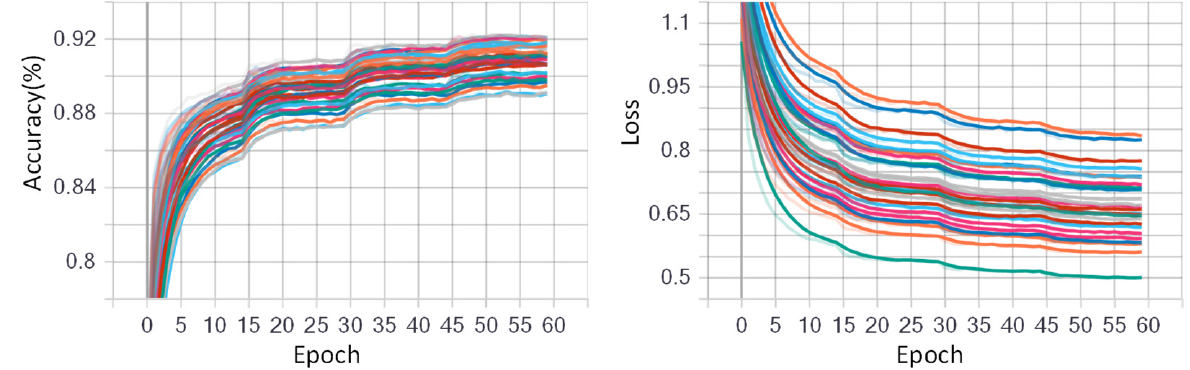
Figure 9. Training progress of fine-tuned GAF-CNN model for low-density dataset NinaPro DB1. The epoch number was set to 60 and different colors denote the 27 different subjects. The different color lines indicate different subjects.